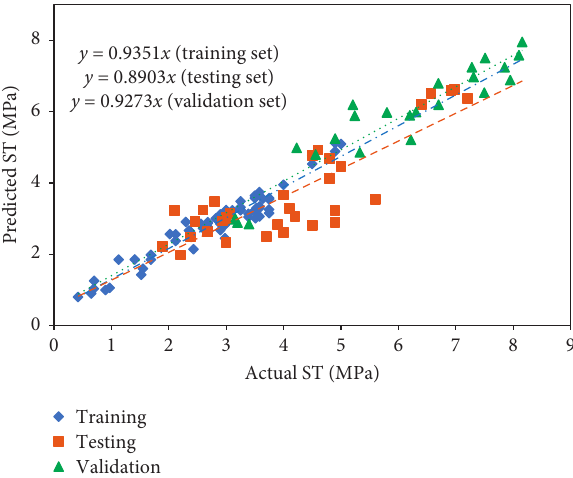
Figure 5: Comparison of actual and predicted ST.